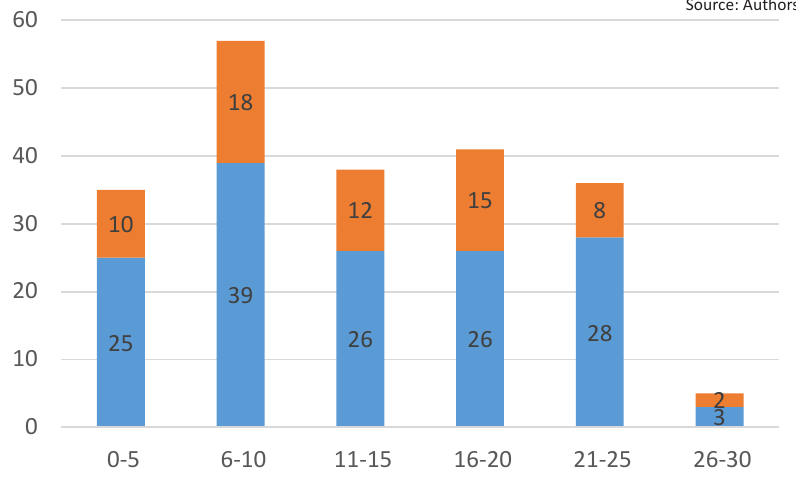
Figure 1. Age structure